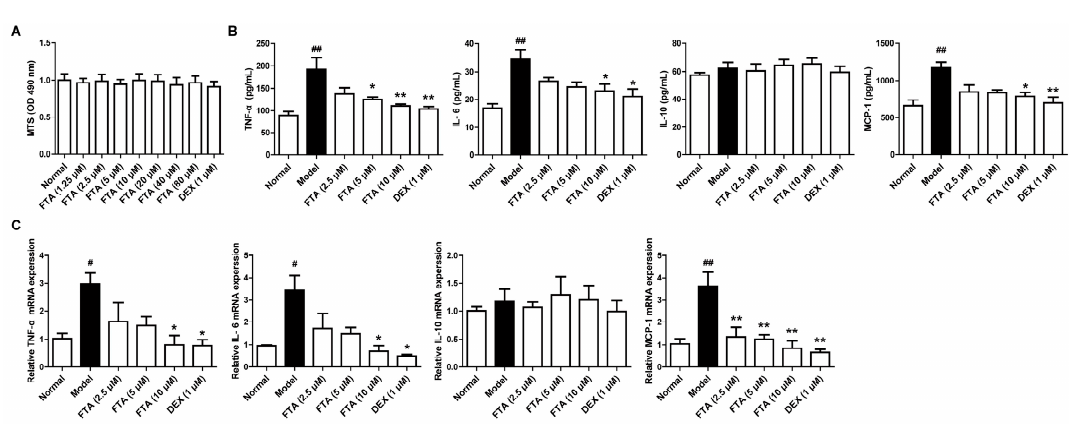
Figure 4. FTA reduces the expressions of cytokines in zymosan-stimulated RAW 264.7 cells. Cells were pretreated with zymosan (10 μ g/mL) for 30 min, then treated with FTA (2.5, 5, 10 μ M) and DEX (1 μ M) for 4 h, and supernatants and total cells were collected. ( A ) Effect of FTA on the cell viability of macrophage RAW 264.7 cells. Cells were incubated with or without FTA (1.25–80 μ M) and DEX (1 μ M) for 24 h. Cell viability was determined by MTS; ( B ) The protein of cytokines were determined by ELISA; ( C ) Cytokine mRNA levels were quantified by QRT-PCR. Data were expressed as means ± SEM ( n = 3). * p < 0.05, ** p < 0.01 vs. Model; # p < 0.05, ## p < 0.01 vs. Normal.